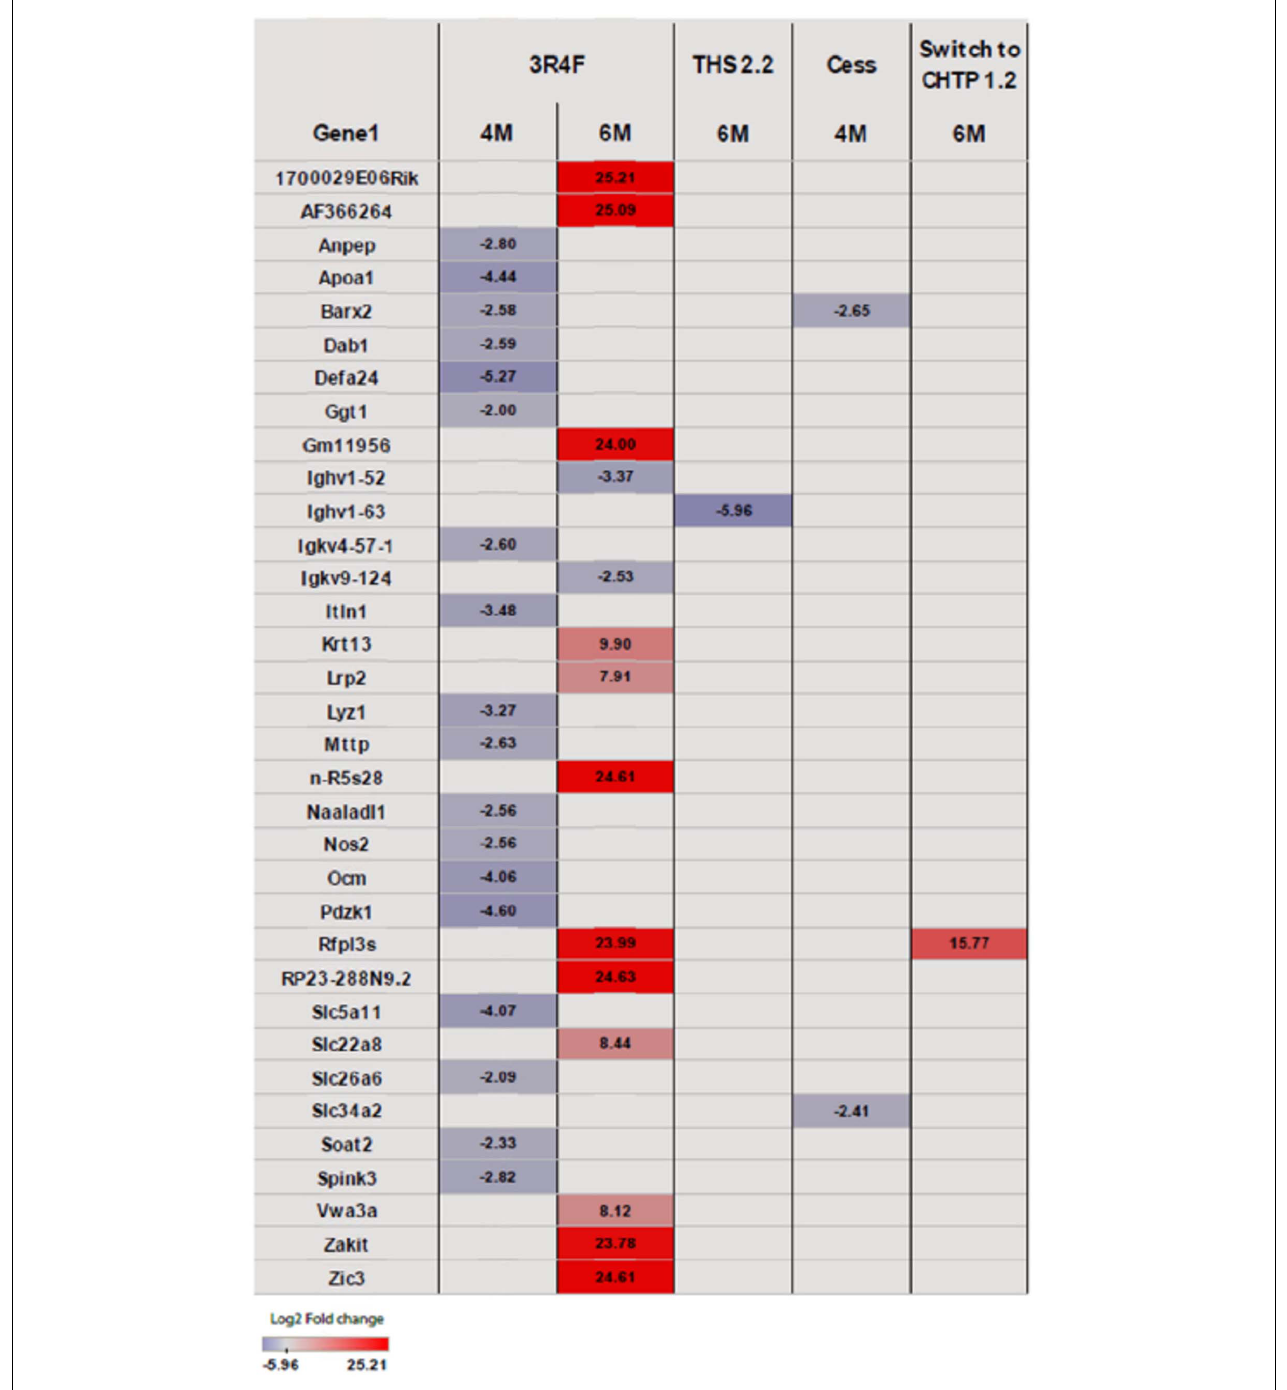
FIGURE 5 | Heat map representing differentially expressed genes in the cecum. Blue indicates significantly ( p <= 0.05) decreased expression, and red indicates significantly increased expression. The intensity of coloring varies with log2 fold